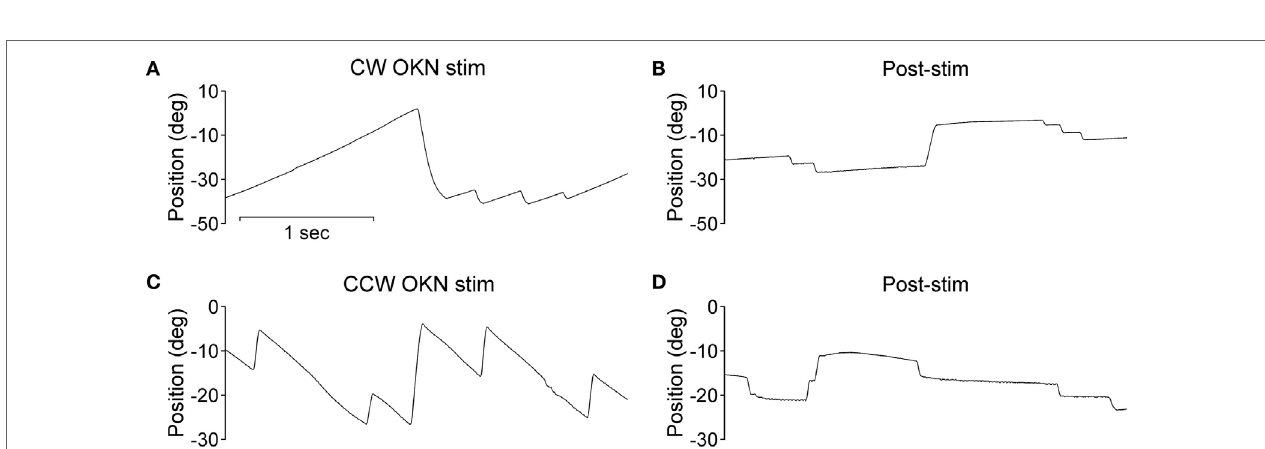
FigUre 4 | Optokinetic nystagmus (OKN) and afternystagmus of the healthy subject. Plots on the left demonstrate eye position traces during optokinetic stimulation in (a) CW (clockwise) and (C) CCW (counterclockwise) directions. Plots on the right demonstrate eye position traces in darkness subsequent to the 10-min optokinetic stimulations in (B) CW (clockwise) and (d) CCW (counterclockwise) directions. OKN stim, optokinetic stimulation phase; post-stim, post- stimulation phase.